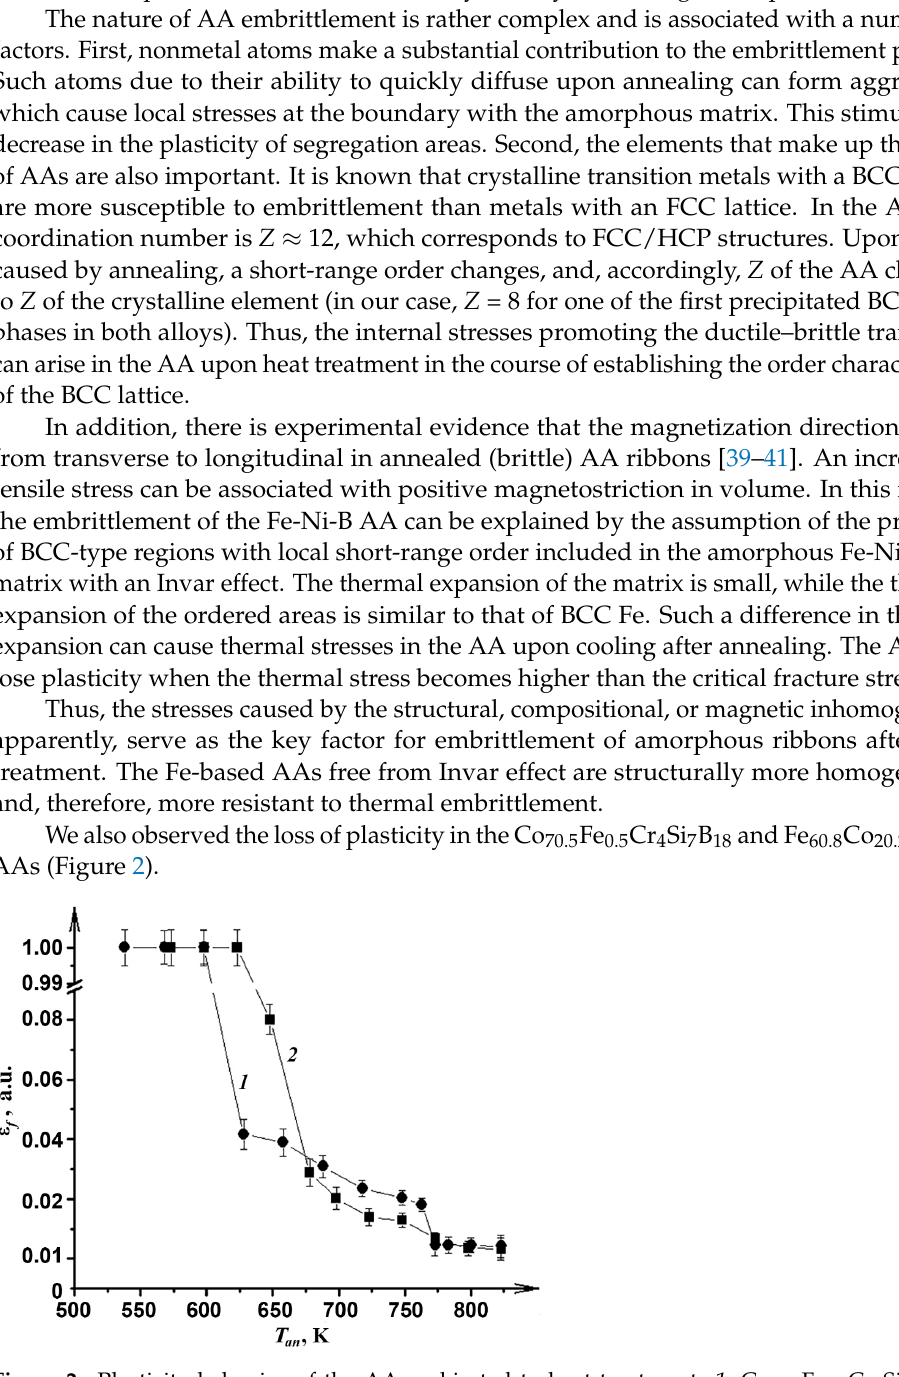
Figure 2. Plasticity behavior of the AAs subjected to heat treatment: 1 , Co 70.5 Fe 0.5 Cr 4 Si 7 B 18 ; 2 , Fe 60.8 Co 20.2 B 14 Si 5 . It is shown that both AAs pass into a brittle state in two stages. The first abrupt decrease in ε f (from 1.0 to 0.04–0.08) is observed at temperatures of 625 K and 650 K, respectively, and the second, less abrupt decrease (virtually to zero from 0.04 for the former alloy and from 0.08 for the latter alloy) is stretched over heat treatment intervals of 625–775 K and 650–775 K, respectively. A detailed analysis of the microindent and the plastic deformation zone of numerous diverging “rays” of shear bands (Figure 3) occurring upon indentation allows us to estimate the degree of local plasticity of the AAs. Figure 3. Typical microscopic image of the plastic deformation of AA after indentation with Vickers indenter. A surface density of plastic deformation zones ( ρ ) as the number of shear bands reduced to unit area can be used as the criterion for the resulting degree of microdeformation, which changes upon heating. The parameter ( ρ ) at the specified T an